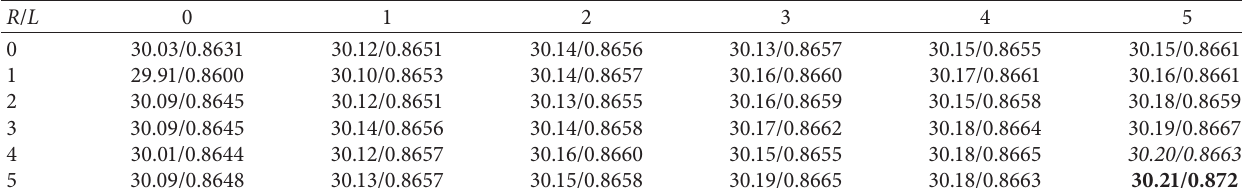
Table 5: The performances (PSNR/SSIM) under different L and R on DSLR-based City100 database ( G � 6 and T � 3 fixed). R / L 0